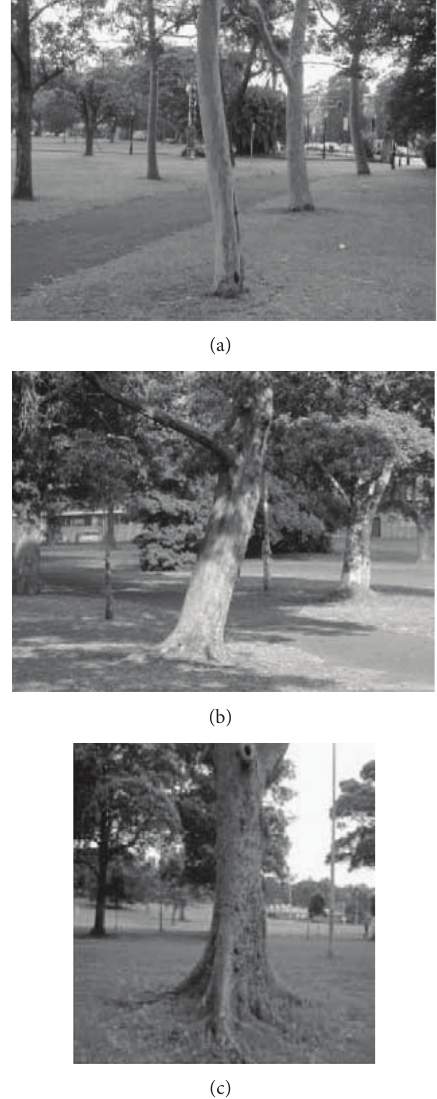
Figure 3: Trees with different shape, size and